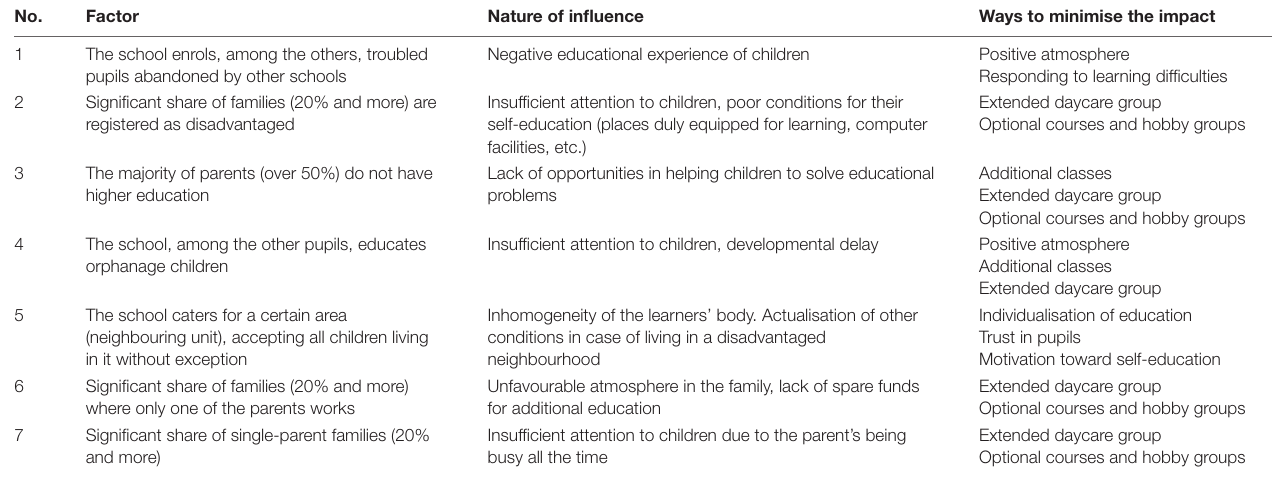
TABLE 5 | Ways to minimise the factors negatively affecting the efficiency of